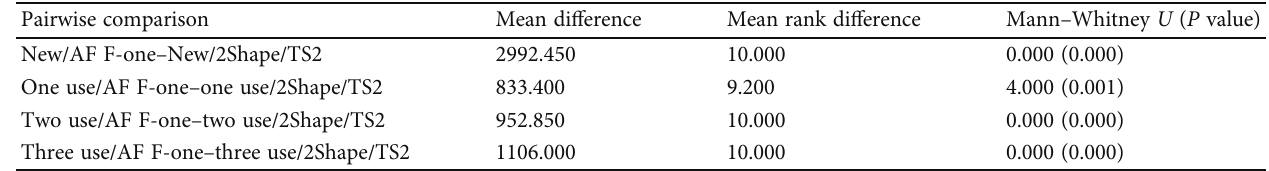
Table 5: Between groups non-parametric pairwise comparison